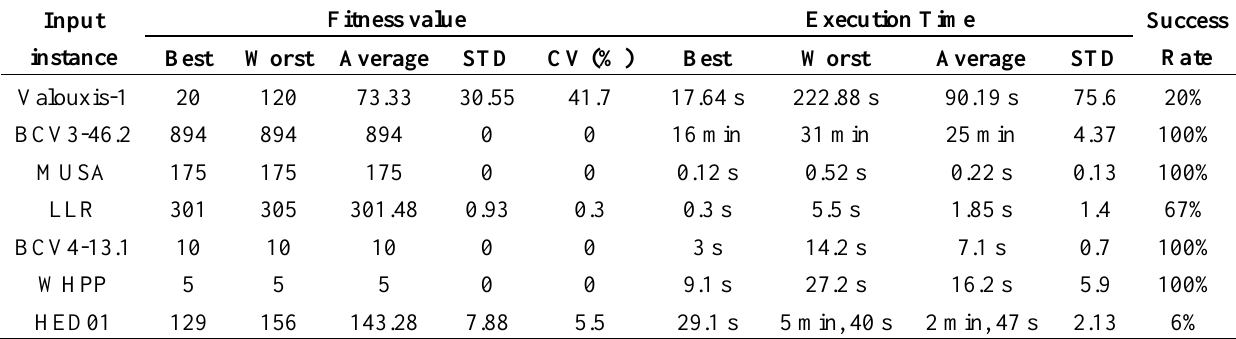
Table 4. Computational experiments demonstrating the efficiency, stability and homogeneity of the proposed algorithm. STD, standard deviation; CV, coefficient of